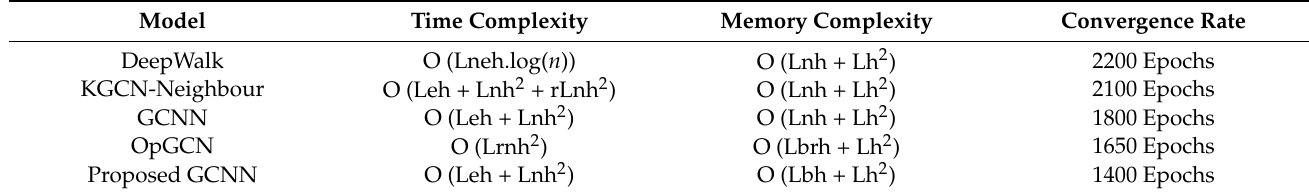
Table 4. Complexity (time and memory) and convergence rate comparison.